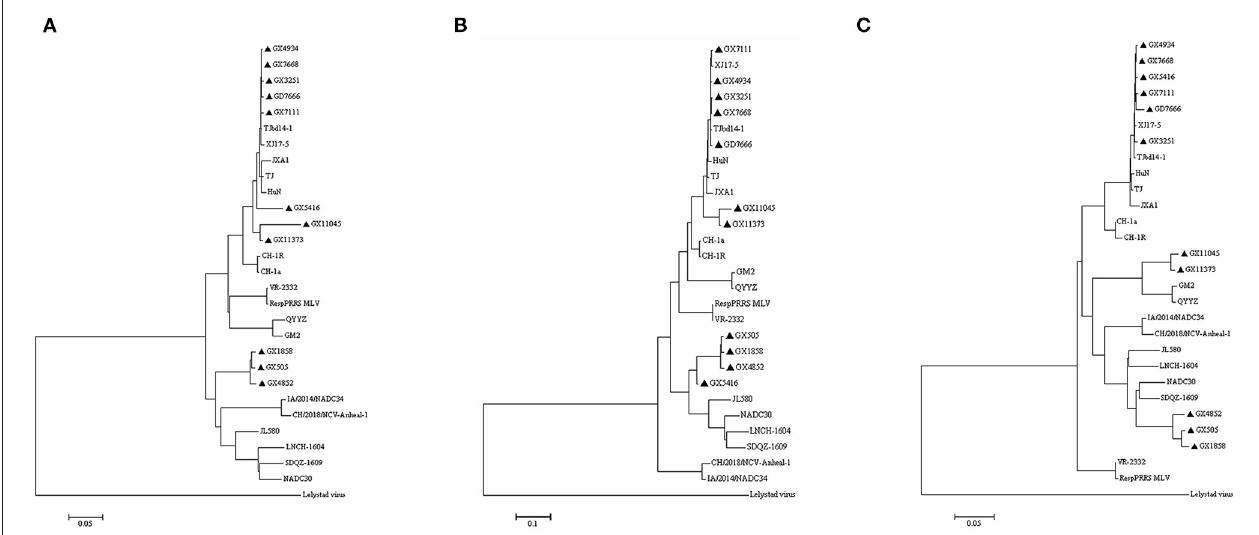
FIGURE 6 | Phylogenetic trees based on the complete genome, nsp2, and ORF5 of PRRSV. (A) Complete genome nucleotide; (B) Nsp2 nucleotide; (C) ORF5 nucleotide. The isolates recovered in this study are indicated by black triangles.